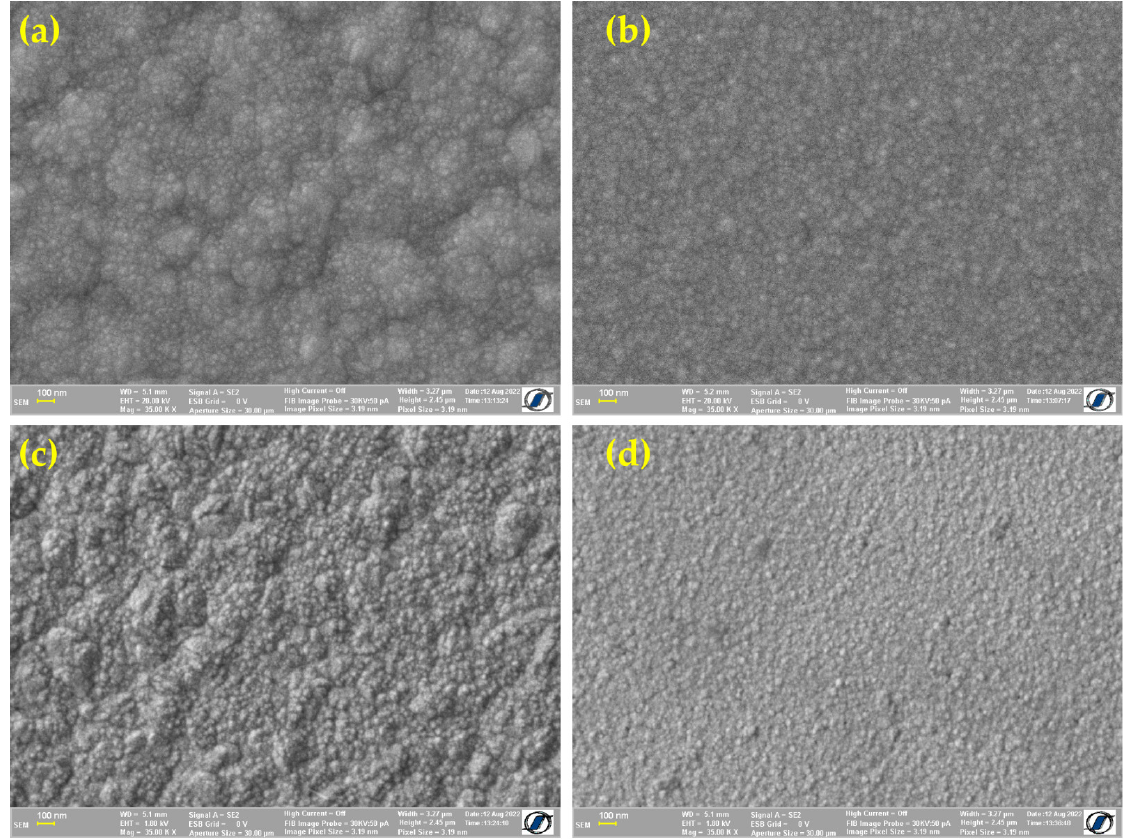
Figure 2. HR-SEM images of electrodeposited CoPt alloy for various electrodeposition solutions. ( a ) pH = 2.5 solutions without saccharin addition, ( b ) pH = 2.5 solutions with saccharin addition, ( c ) pH = 5.5 solutions without saccharin addition and ( d ) pH = 5.5 solutions with saccharin addition.